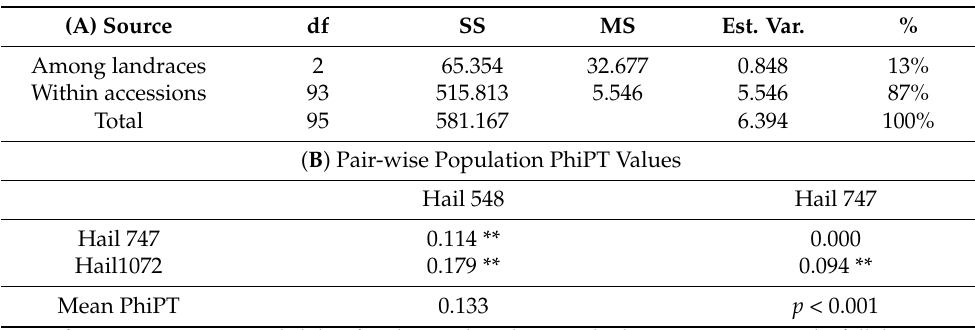
Table 3. Summary of analysis of molecular variance (AMOVA) ( A ) and population differentiation index ( B